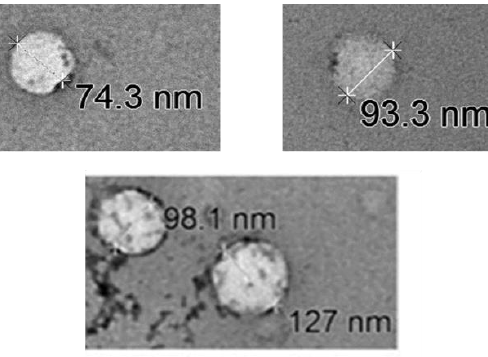
Figure 2. Representative Transmission Electron Microscopy images. Exosome sizes ranging from 74 to 127 nm at a maximal magnification of 90.000 via direct magnification.